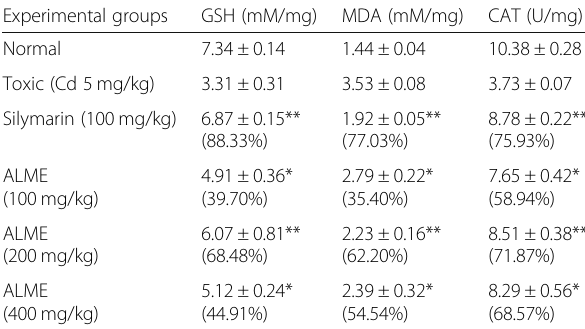
Table 3 Effect of ALME on different antioxidant parameters in the liver tissue Experimental groups